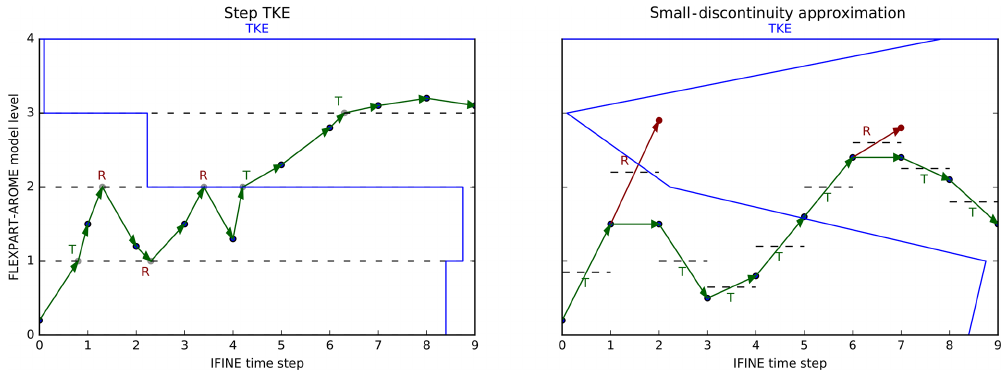
Figure 2. Illustrative difference between Step TKE and SDA configurations. Dashed lines represent TKE interfaces; in the Step TKE config- uration they are fixed with homogeneous TKE regions in between; SDA interpolates TKE to the particle position and initializes an imaginary temporary TKE interface halfway along the particle trajectory at each step. Every time the particle tries to cross an interface we evaluate the probability of crossing, and the particle will be either transmitted ( T ) through or reflected ( R ) at the interface. The Step TKE configuration updates particle positions to the boundary before computing the probability of crossing (gray points); when particles are transmitted, their turbulent velocity is adapted to the new model layer. The SDA configuration uses a virtual position which becomes the new position upon transmission or which is never realized upon reflection (red